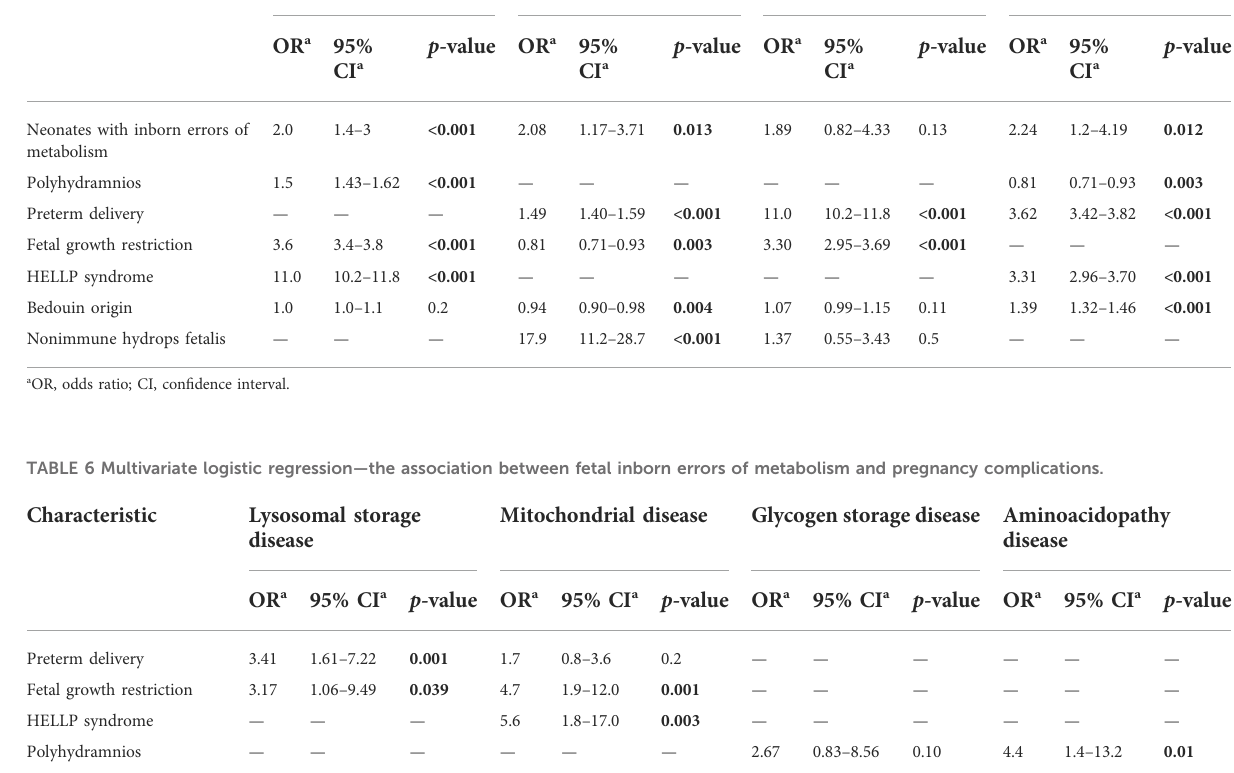
TABLE 5 Multivariatelogistic regression — the association between clinical risk factorsand the deliveryof neonateswith inborn errors of metabolism. Characteristic